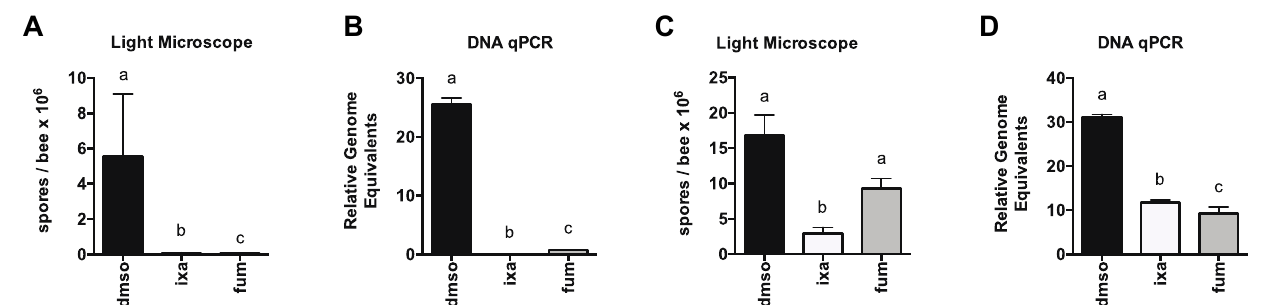
Figure 3. Proteasome inhibition reduces N. ceranae infection intensity in experimentally or naturally infected honey bees. N. ceranae levels in midguts as determined by spore count using light microscopy ( A ) or by qPCR ( B ) 8 days post infection in uninfected or infected landing board bees fed sucrose solution containing DMSO or ixazomib for the final 4 days. N. ceranae levels as determined by spore count using light microscopy ( C ) or by qPCR ( D ) in individual landing board bees from an infected colony captured and fed sucrose solution containing DMSO or ixazomib for 2 days, a ≠ b ≠ c, p < 0.05..